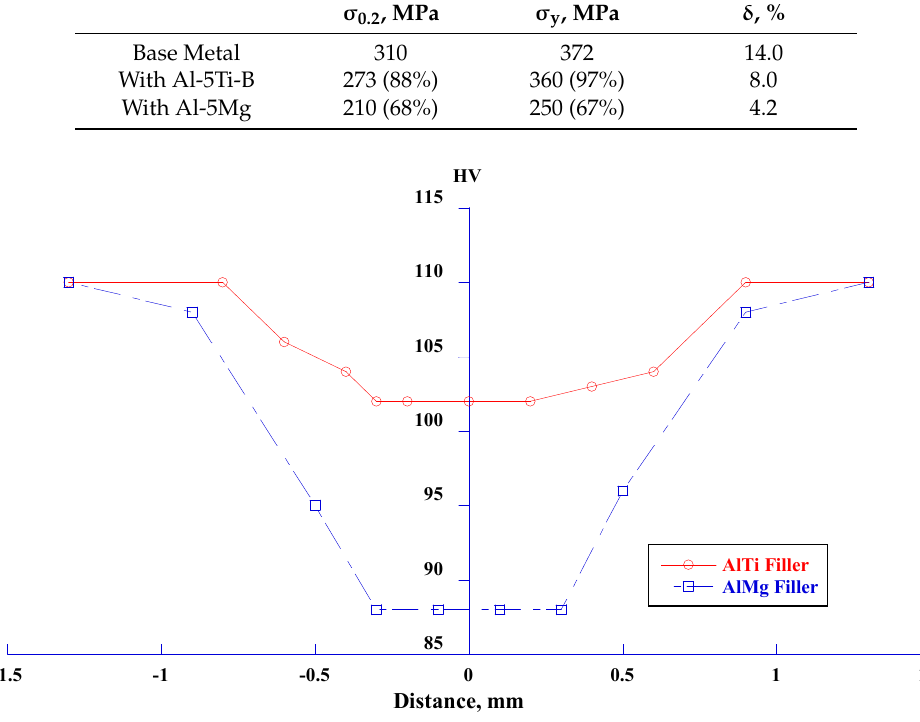
Figure 9. Micro hardness of the cross section of the weld joint of AA7020.